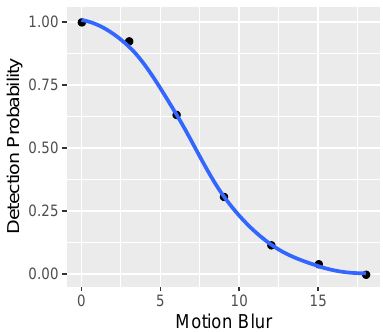
Figure 8. Face Recognition detection [probability] for Gaussian noise [ σ /pixels].